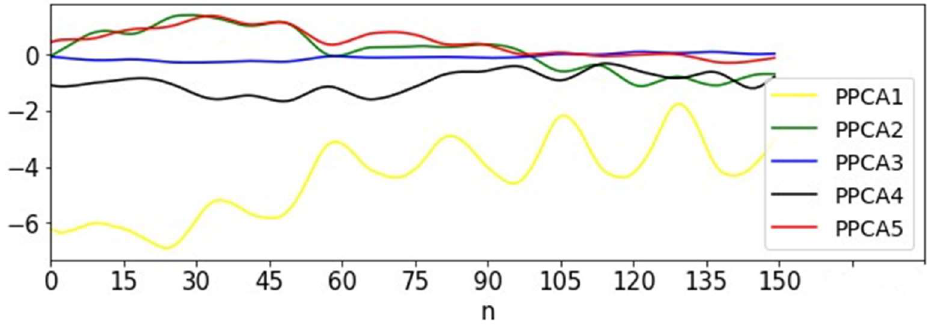
Figure 14. The first 5 principal components after data pre-processing from the compressor data. Table 10. Error results of STGP and MTGP (with data